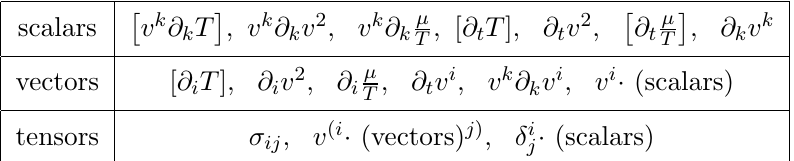
Table 1 . An overview of all the di(cid:11)erent one-derivative terms of the thermodynamic variables we can write down, with respect to the symmetries of the system. The parentheses around the indices denote a symmetric tensor, since T i j = T j i . The terms in square brackets are the terms we eliminate using the equations of motion at zeroth order. Here (cid:27) ij = @ i v j + @ j v i shear tensor and d is the number of spatial dimensions. Note that we do not decompose the vectors into components transverse to the velocity, since we are also interested in situations where v i =